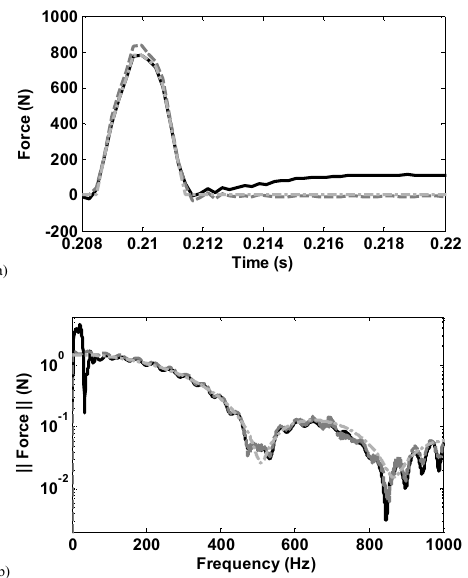
Fig. 28. The adjusted, curve-fit force (– · – · ) better matches the value and shape of the actual force (– – –) than the original estimate (——) in both the a) time and b) frequency domains. acting on a structure with multiple input locations using only one multi-directionalsensor when the structure becomes damaged due to the impact. Both force estimation techniques investigated in this paper are applied in the frequency domain. The first technique discussed is a shaped-based technique applied previously. The second method is new and is based on the amplitude of the estimated force. The shape-based technique relies on the assumption that the applied force is impulsive, but the amplitude-based technique requires no such assumptions. The